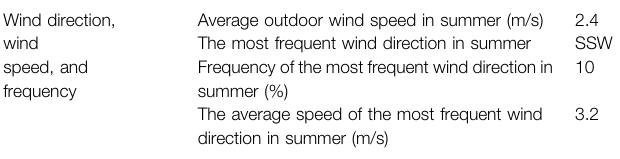
TABLE 1 | Dominant wind direction, and wind speed in summer in Xinyang